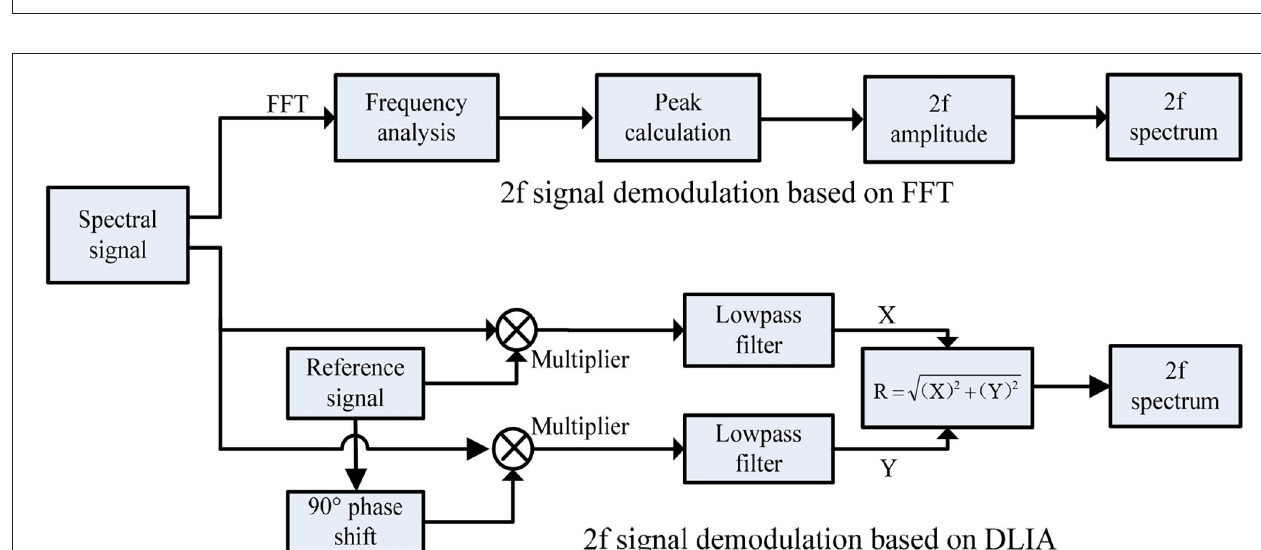
FIGURE 3 | Flowchart of two signal demodulation